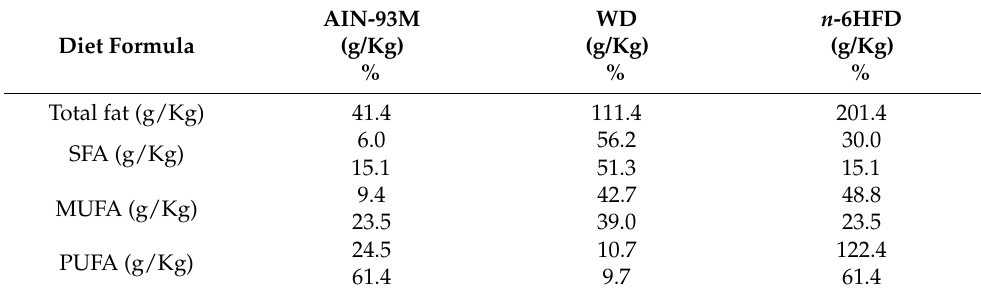
Table 3. Fatty Acid Composition of Diets a